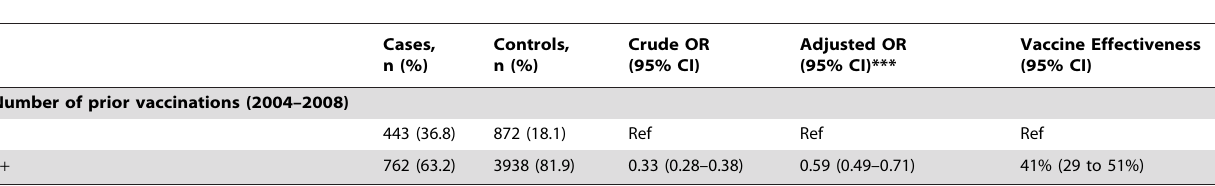
Table 4. Crude and Adjusted OR for Service Members with a Documented History of Receiving Previous Influenza Vaccines.